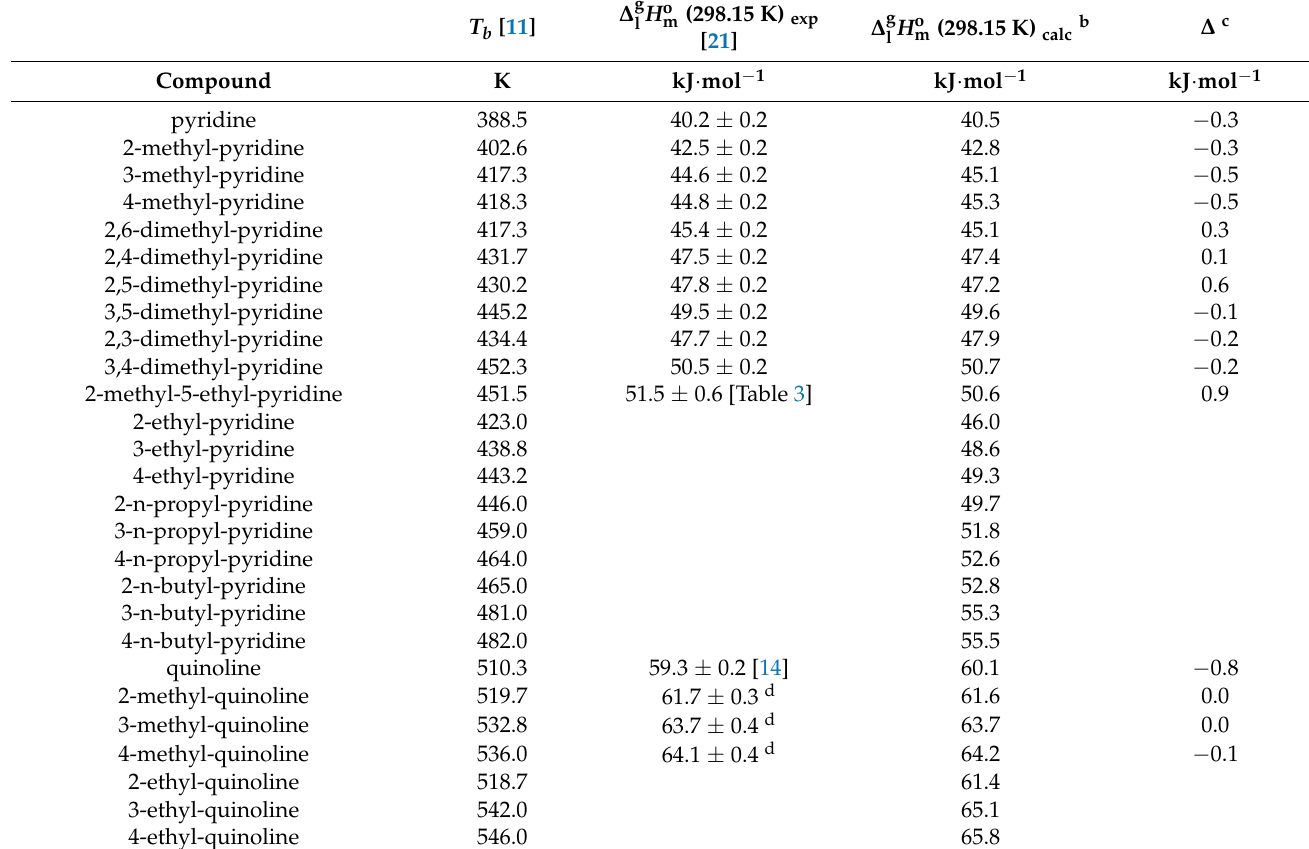
Table 8. Correlation of vaporization enthalpies ∆ g normal boiling temperatures a